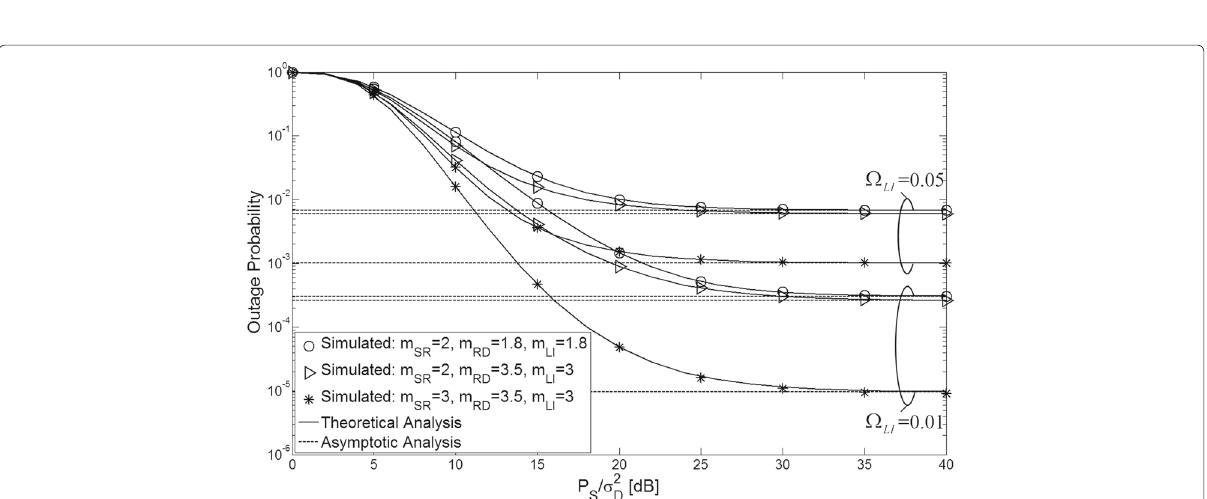
Fig. 3 Outage probability of the variable-gain AF-FD systems for (cid:6) LI = { 0.01,0.05 } , γ th = 1 and various m